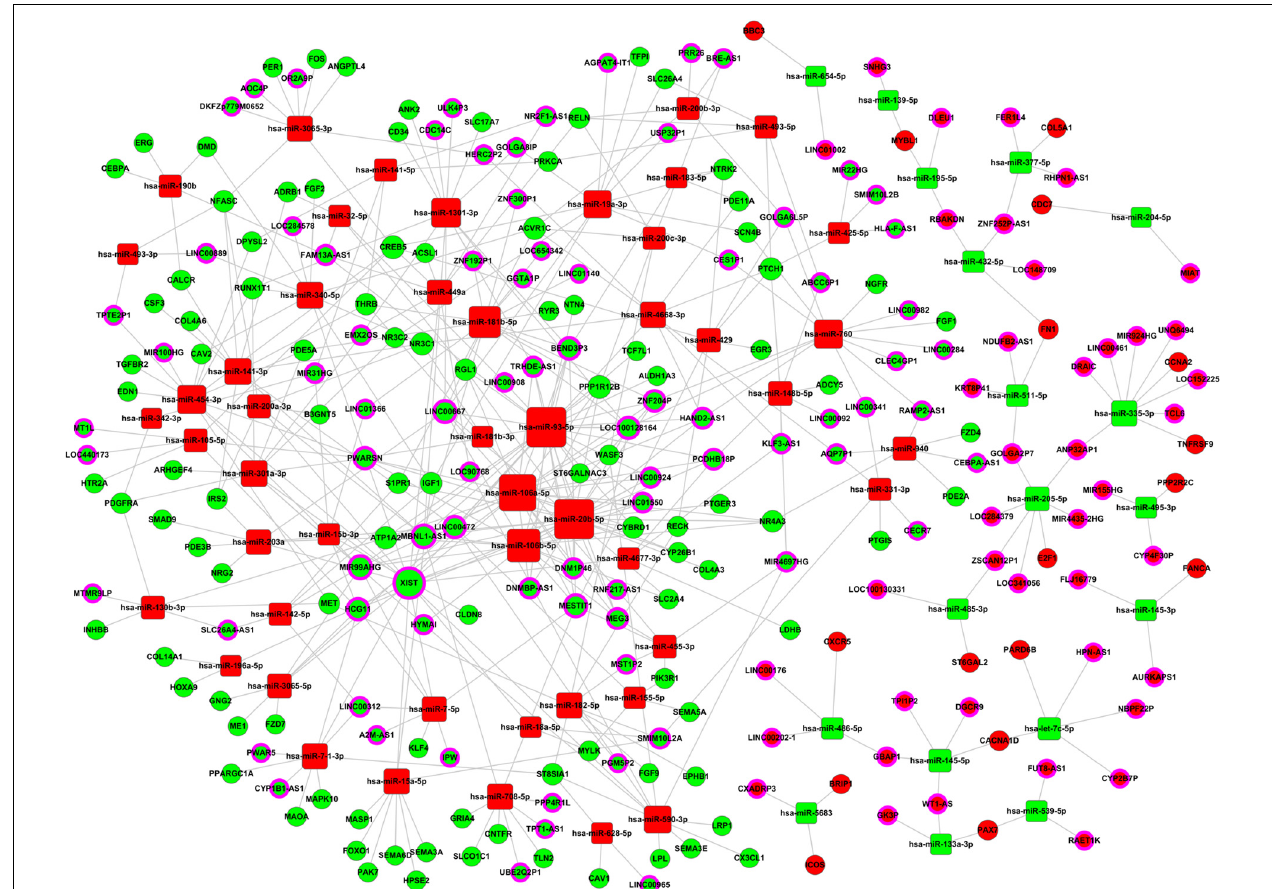
FIGURE 3 | LncRNA–miRNA–mRNA regulatory network. Squares represent miRNAs, balls represent mRNAs, and balls with a circle around represent lncRNAs. Red means upregulated genes, while green means downregulated